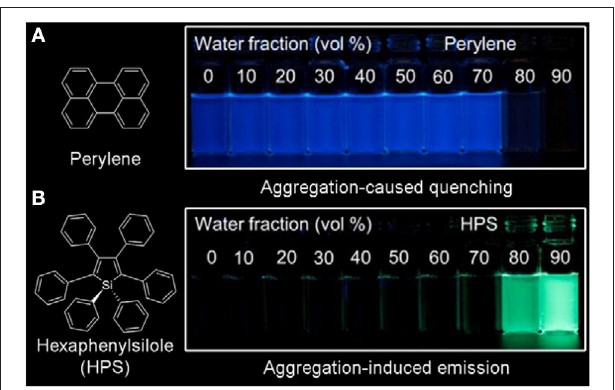
FIGURE 1 | Fluorescent photographs of (A) perylene and (B) hexaphenylsilole (HPS) in THF/H 2 O mixture containing different water fractions under 365nm UV irradiation (reproduced with permission from Mei et al., 2015; Copyright 2015 American Chemical